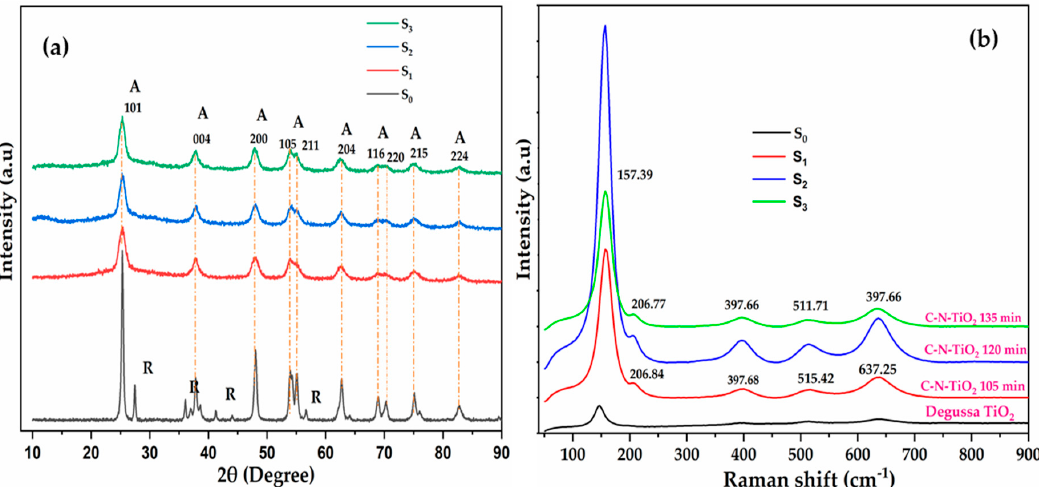
Figure 1. ( a ) X-ray diffraction (XRD) and ( b ) Raman analysis of TiO 2 Degussa (S 0 ) and the synthesised C–N–TiO 2 nano catalysts pyrolysed at 350 °C, a ramping rate of 50 °C/min at different holding times (105 min (S 1 ), 120 min (S 2 ), and 135 min (S 3 )) with A = anatase and R = rutile. Table 1. Summary of the average particle sizes of TiO 2 Degussa and the synthesised C–N–TiO 2 photo catalysts estimated from XRD analysis using the Scherer equation.